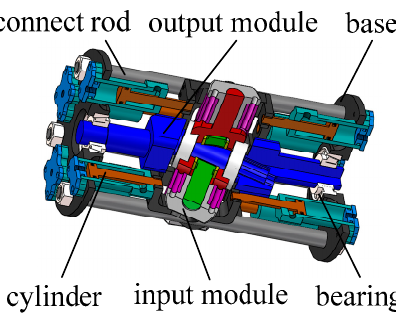
Energies 2018 , 11 , x FOR PEER REVIEW Figure 4. The structure diagram of the wobble plate joint. Figure 4. The structure diagram of the wobble plate joint.